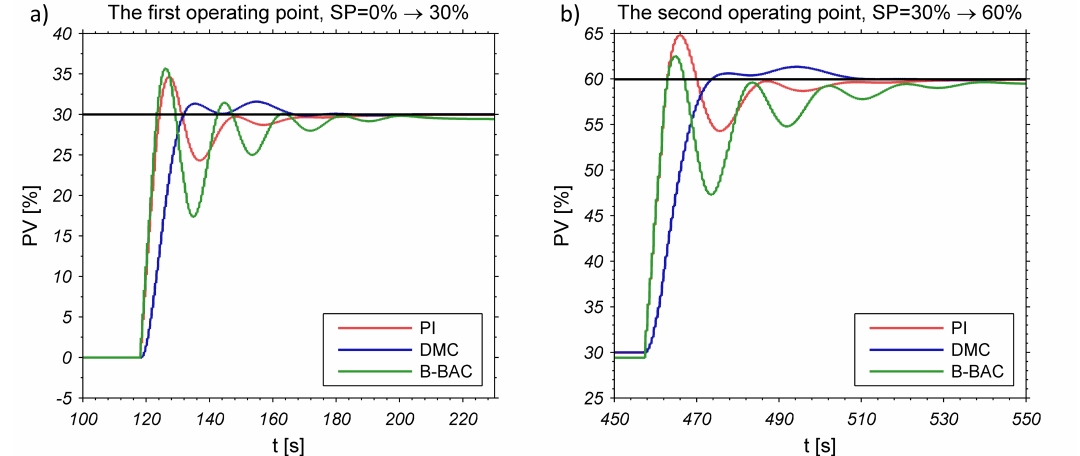
Figure 7: Control system responses with the plant K 3 ( s ) to step changes in the SP value: a) for the first operating point (SP change at 100[s]); b) for the second operating point (SP change at